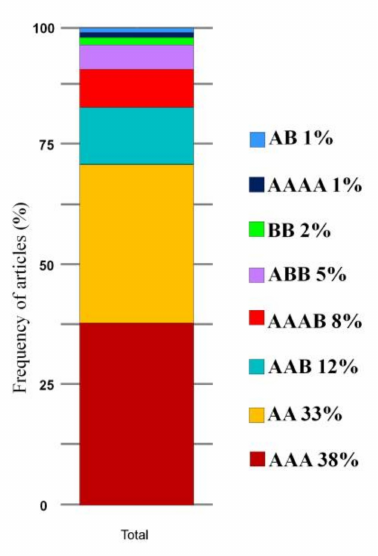
Figure 8. Frequency of genomes associated with sources of resistance to Fusarium wilt in studies on banana breeding carried out in the last ten years.